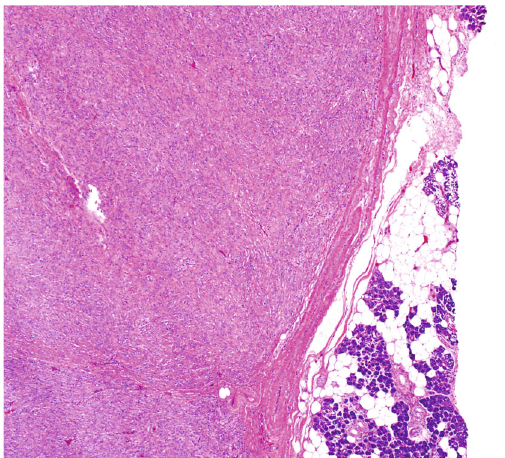
Figure 1: An axial MRI image demonstrating a lobulated lesion centered within the super fi cial lobe parotid gland (right side). Figure 2: The lesion with well-de fi ned border and showed a thin fi brous capsule. Unremarkable salivary gland tissue noted in the periphery (H&E, × 10).